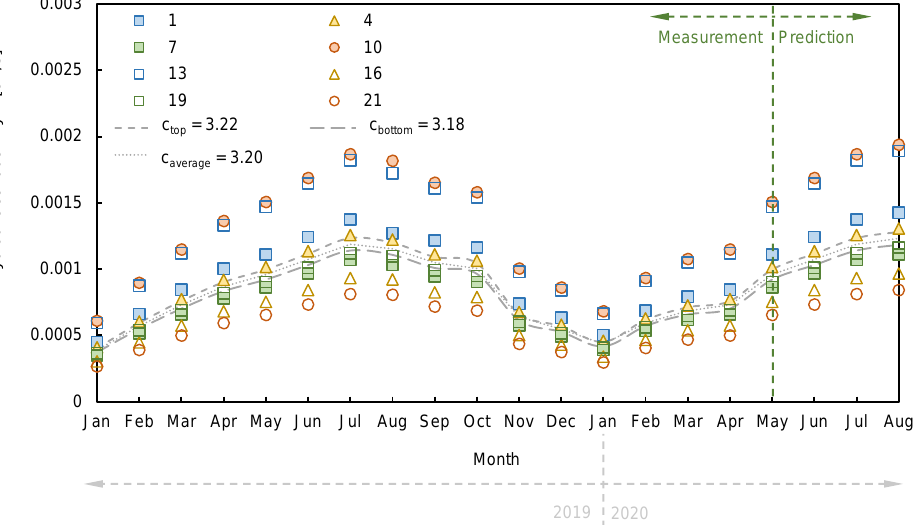
Figure 12. Distribution of hydraulic conductivity according to a time series.